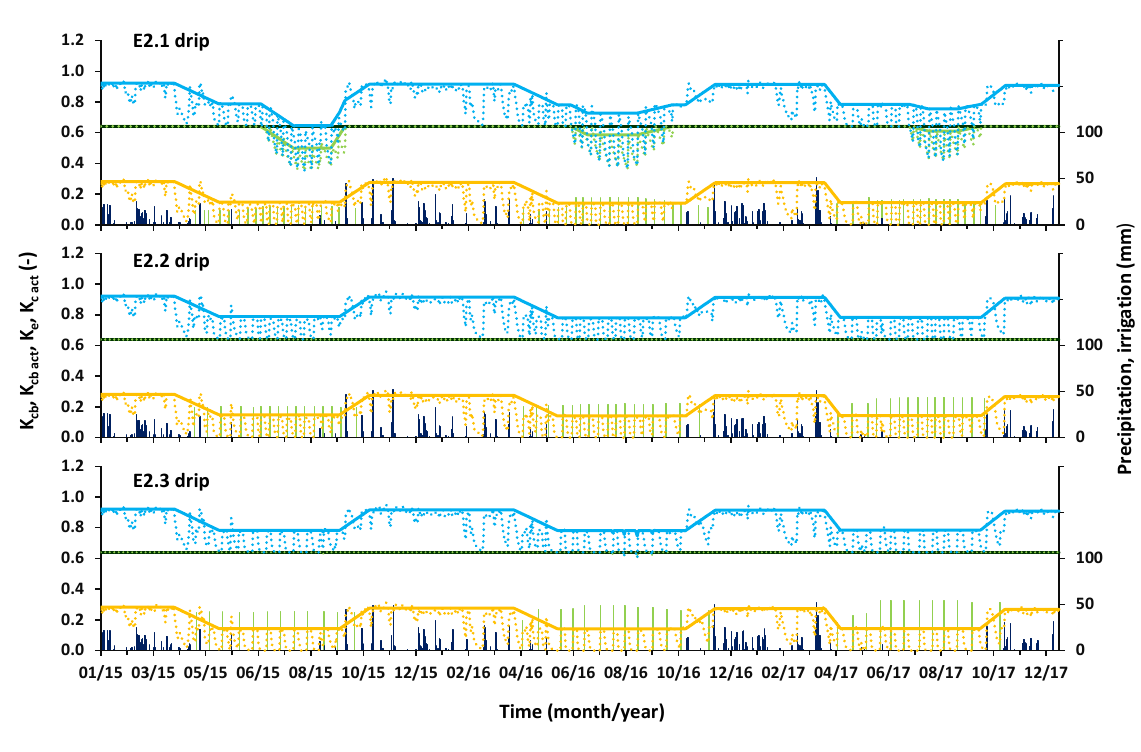
Figure 8. Seasonal variation in the standard (non-stressed) basal crop coefficient (K cb ), the actual basal crop coefficient (K cb act ), and the evaporation coefficient (K e ) in E2 plots during the 2015–2017 growing seasons, including the respective data on irrigation and precipitation.